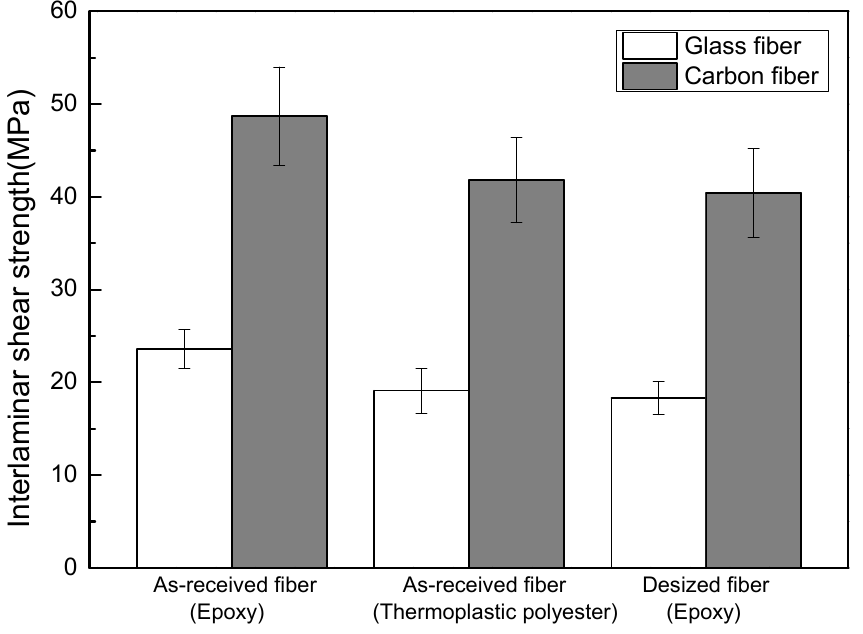
Figure 9. Average ILSS value of specimens.